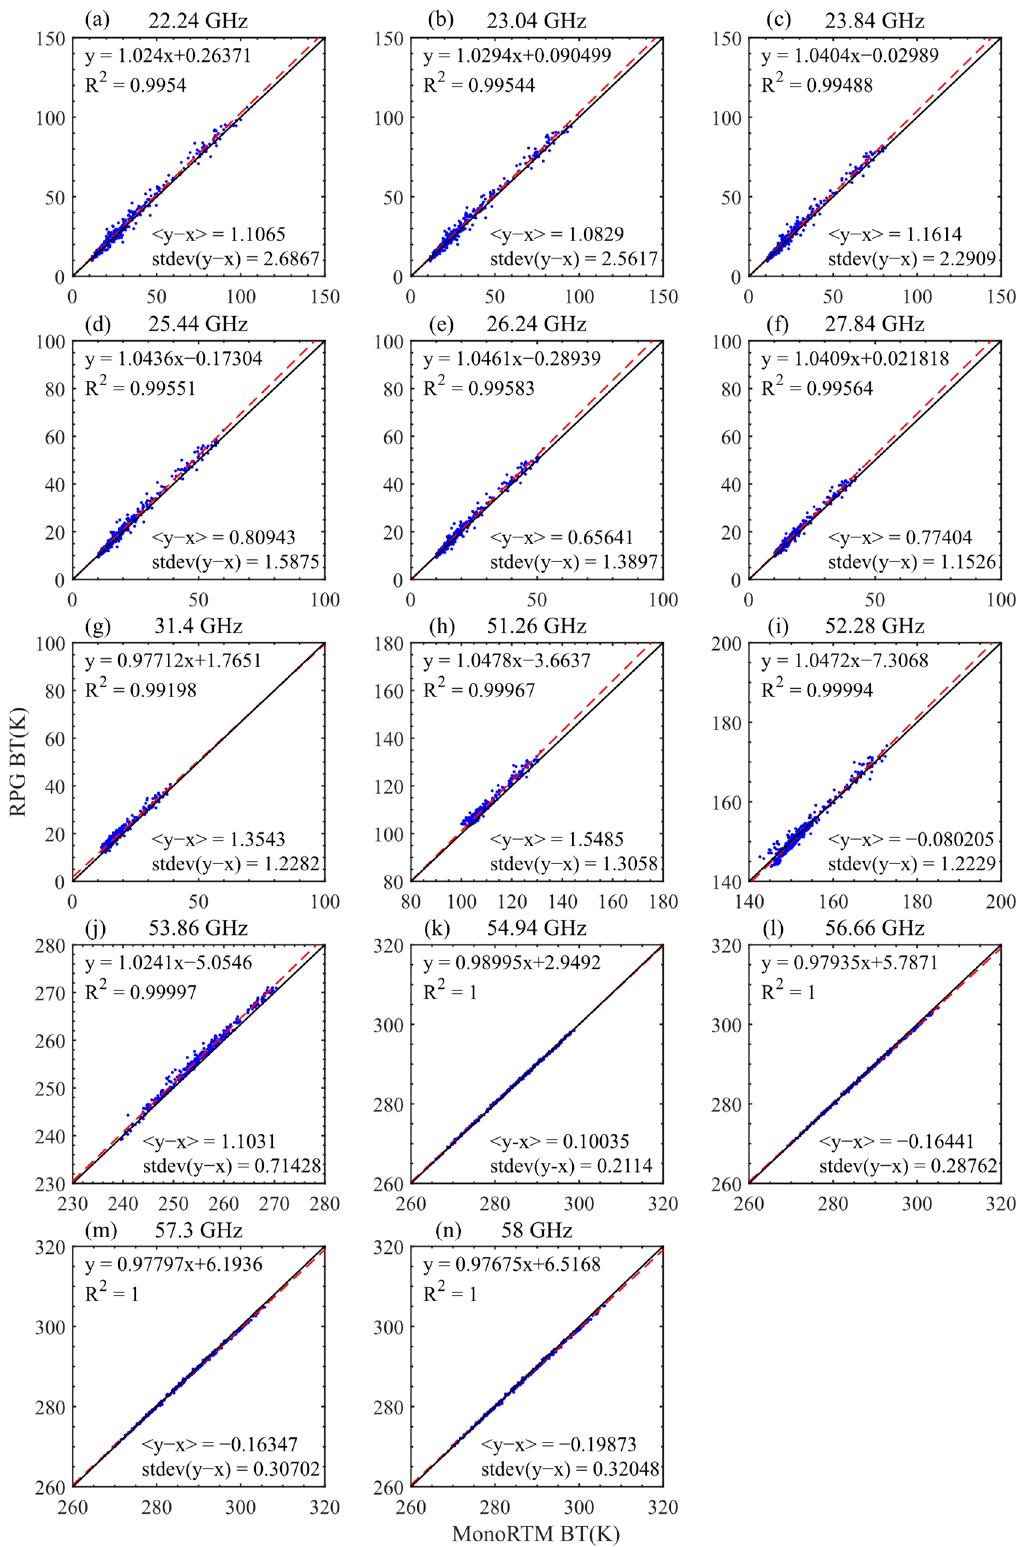
Figure 3. Scatter diagrams of observed BTs and simulated BTs in the clear sky (the red dashed lines denote fitting straight lines). ( a ) 22.24 GHz, ( b ) 23.04 GHz, ( c ) 23.84 GHz, ( d ) 25.44 GHz, ( e ) 26.24 GHz, ( f ) 27.84 GHz, ( g ) 31.40 GHz, ( h ) 51.26 GHz, ( i ) 52.28 GHz, ( j ) 53.86 GHz, ( k ) 54.94 GHz, ( l ) 56.66 GHz, ( m ) 57.30 GHz, and ( n ) 58.00 GHz. 3.3. Characteristics Analysis No-Precipitating Cloudy Brightness Temperature Data